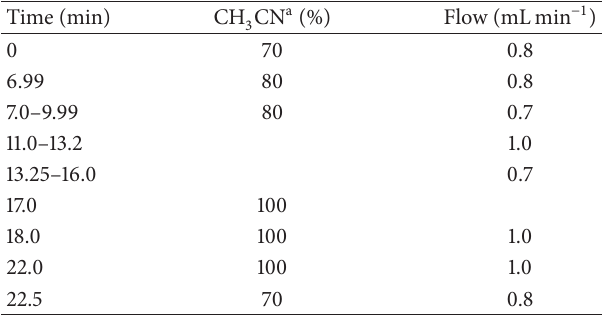
Table 1: Gradient used for the UFLC separation of the 16 PAHs.